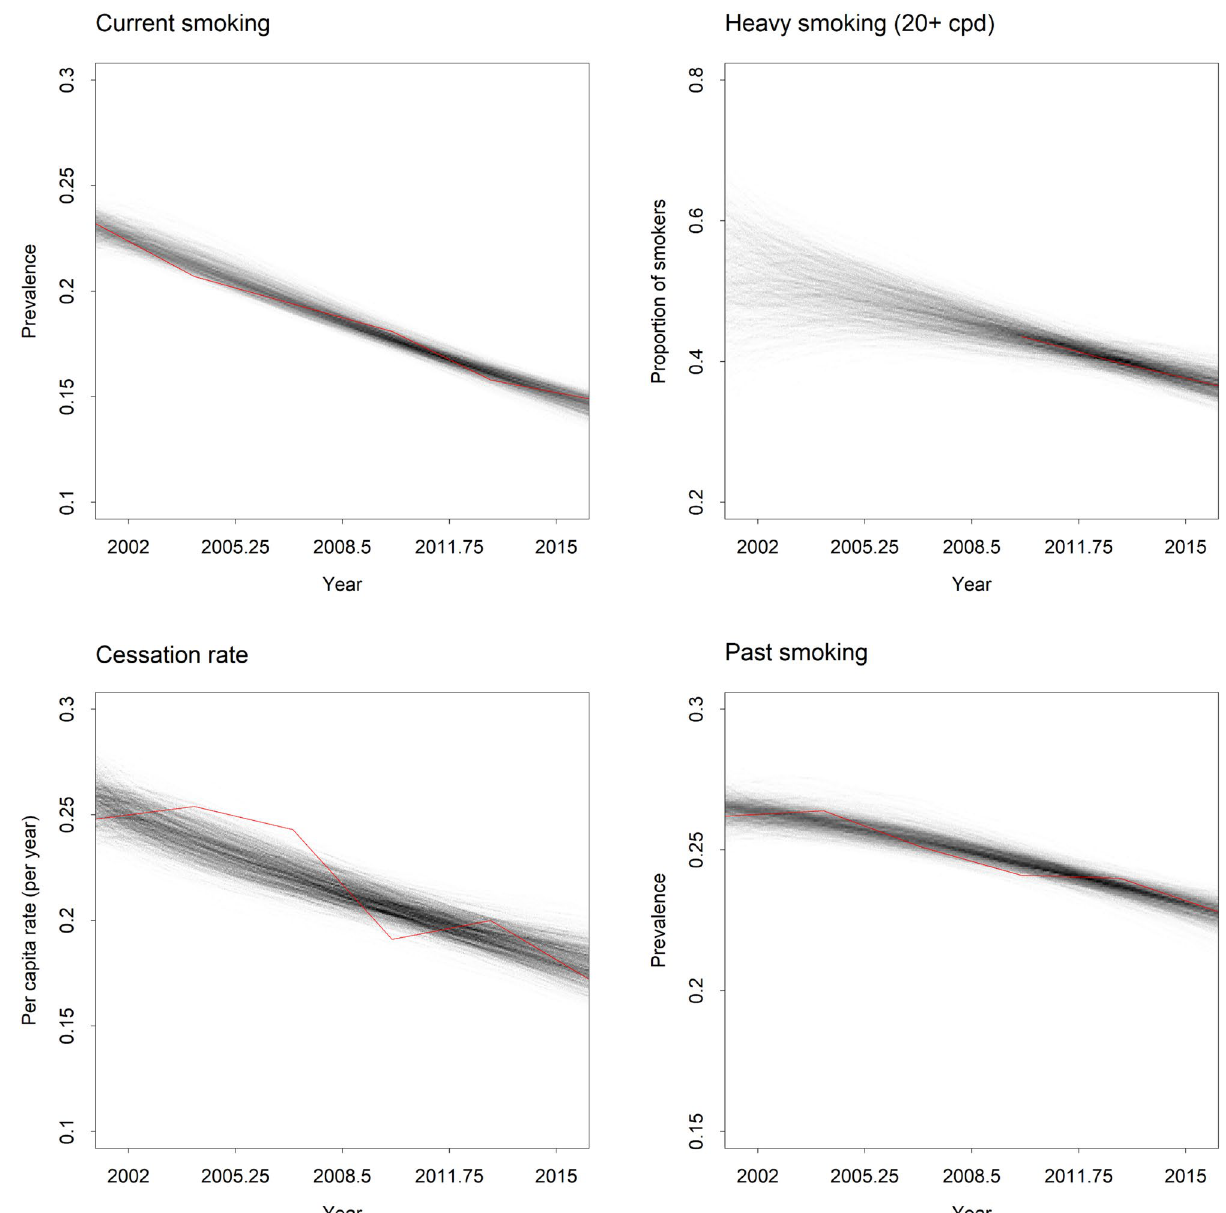
Figure 4. Time-specific posterior density estimates for current smoking prevalence, the proportion of smokers who are heavily dependent, the per capita cessation rate per year, and past smoking prevalence in the Australian population (aged 14 years and above) over the period 2001 ‒ 2016. Density estimates were derived from 10 3 simulations, each of which used a randomly chosen parameter vector ( θ ) sampled in the Markov chain Monte Carlo (MCMC) analysis. Time series data from the National Drug Strategy Household Survey (NHSHS) are plotted in red (note that data on the proportion of smokers who are heavily dependent were available for 2010 ‒ 2016